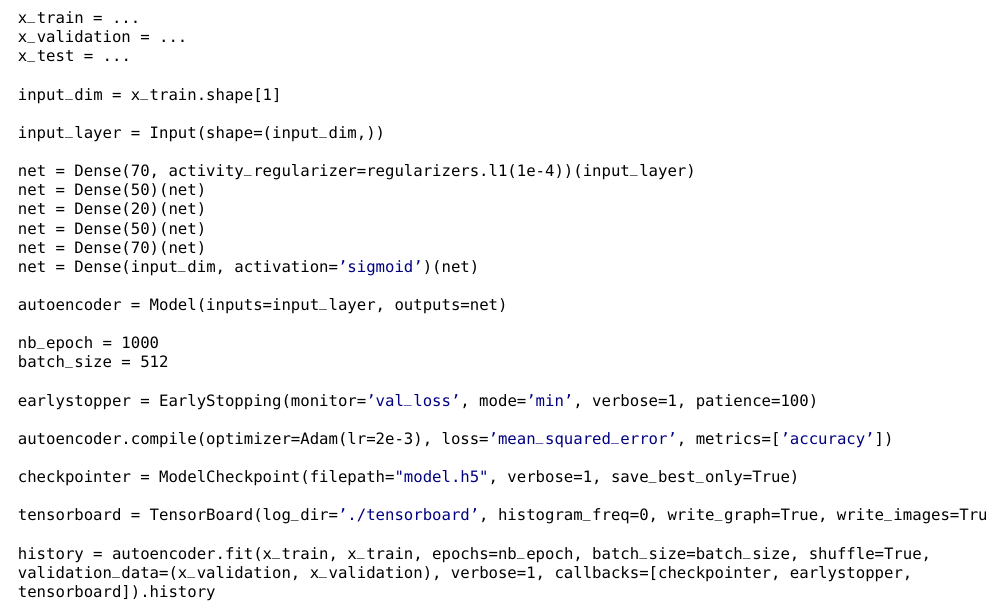
Figure 6. Autoencoder in Tensorflow 2.0 for the CICIDS 2017